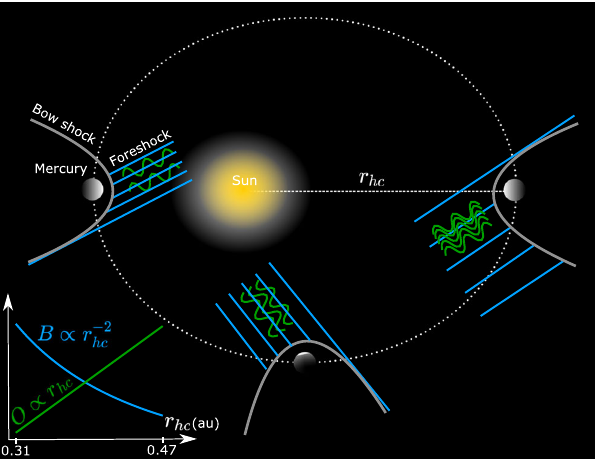
Fig. 8 Illustration of the main result. Schematic representation of the variability of the wave occurrence rate ( O ) and the Interplanetary Magnetic Field (IMF) intensity ( B ) as a function of Mercury ’ s heliocentric distance ( r hc ). The IMF intensity, approximately proportional to r (cid:3) 2 hc , is represented by the distance between light blue lines upstream of each bow shock. In this work, we fi nd that the O increases approximately as r hc , with Mercury ’ s heliocentric distance (represented by the number of green curves upstream of each bow shock). These results are also summarized in the inset plot. These trends are consistent with larger re fl ection of solar wind protons for larger heliocentric distances, associated with higher solar wind Alfvén Mach numbers. The backstreaming protons are the most likely source for the analyzed waves.